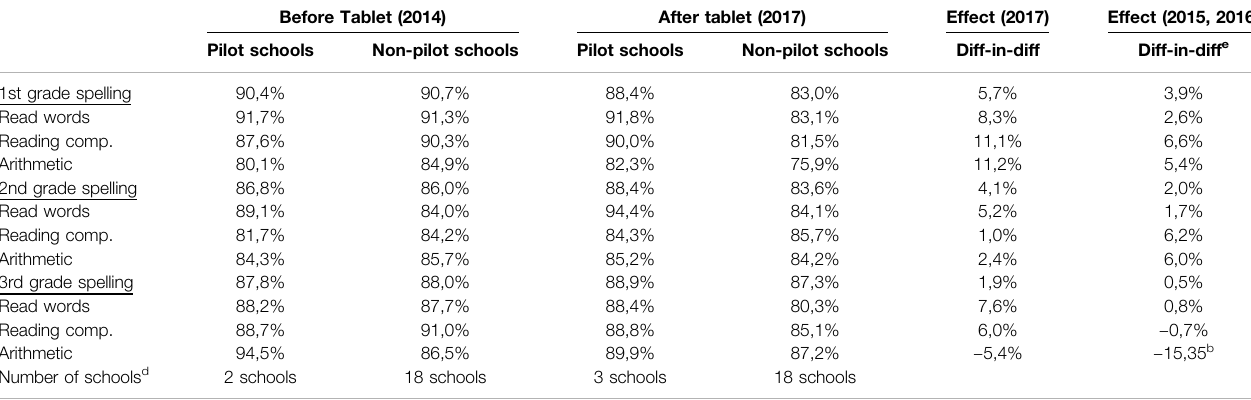
TABLE 9 | Difference-in-difference analysis of share of students above critical limit, fi rst, second, and third grades (group 1). Before Tablet